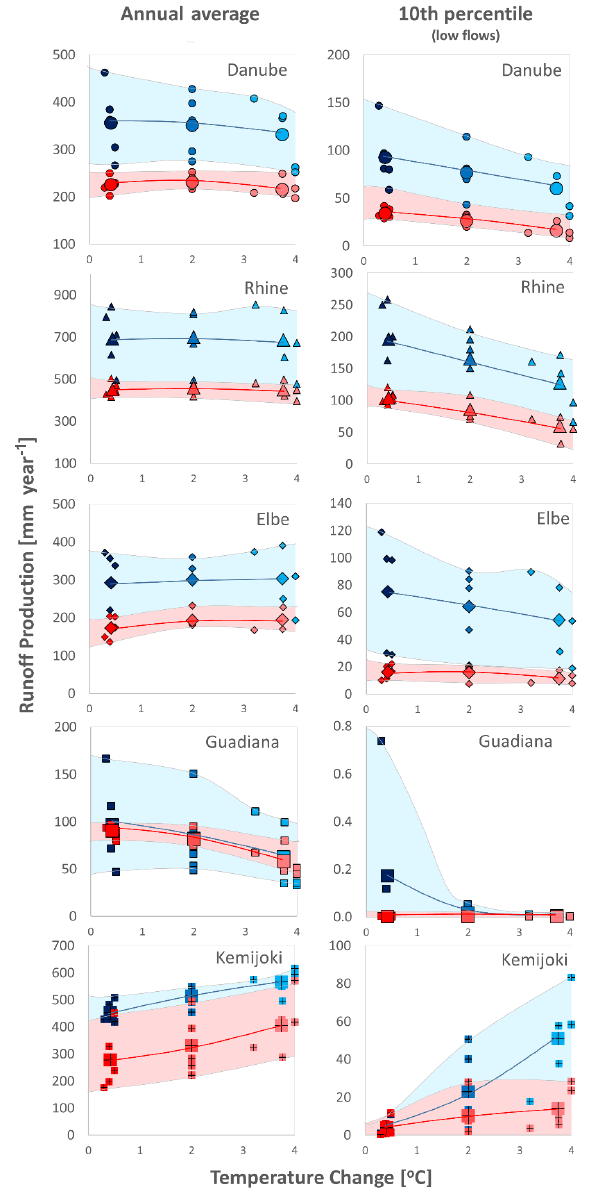
Figure 8. Variation of runoff production with respect to temperature change ( + 2 and + 4 SWLs) for raw (light blue) and bias adjusted (light red) Euro-CORDEX data, for both annual average (left col- umn panels) and 10th percentile (right column panels) runoff pro- duction. Small markers represent the value of each individual model and bigger markers correspond to ensemble mean value.